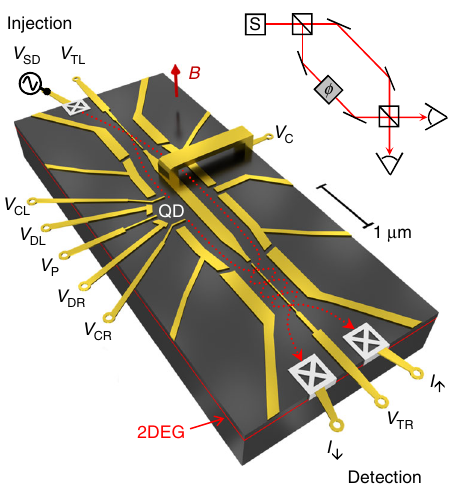
Fig. 1 Scheme of the electron two-path interferometer. Shown is a detailed 3D view on the Schottky gates (golden) de fi ning the conductive paths (red, dotted lines) and the interferometer structure in the two-dimensional electron gas (2DEG) located 110 nm below the surface. The ohmic contacts establishing electrical connection to the 2DEG are schematically indicated via the grey crossed boxes in the terminals of the interferometer. The inset at the upper right depicts the principle of Mach – Zehnder interferometry — the photonic counterpart of our electron